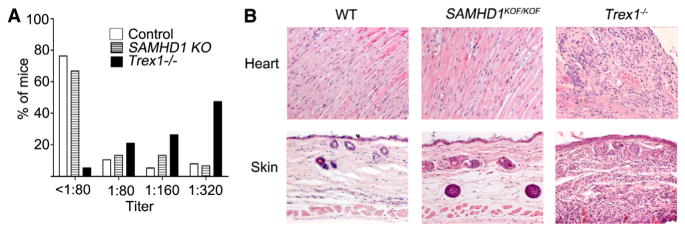
Spontaneous IFN Release Does Not Result in Autoimmune Disease in SAMHD1-Deficient Mice(A) ANAs were detected by immunofluorescence analysis on murine fibroblasts. The significance of differences in ANA prevalence between groups was tested by chi-square test (Pearson) with Bonferroni correction. Autoantibodies occurred more frequently in Trex1−/− mice (n = 19, mean age 10 weeks) compared with controls (Ctrl, p < 0.0001, n = 38, mean age 15 weeks) or SAMHD1-deficient mice (SAMHD1 KO, p < 0.005, n = 15 [this group comprised SAMHD1KOF/KOF and SAMHD1Δ/Δ mice, mean age 20 weeks]). No significant increase in ANA frequencies could be detected in the SAMHD1-deficient versus the control group. (B) Absence of inflammatory changes in heart and skin from SAMHD1-deficient mice. H&E-stained sections of heart and skin from one WT, one SAMHD1KOF/KOF animal, and one diseased Trex1−/− animal from our facility, representative of 13 SAMHD1KOF/KOF mice analyzed (2 mice 16 weeks old, 11 older than 53 weeks) and five SAMHD1Δ/Δ mice (3 mice 9–15 weeks old, 2 older than 43 weeks).See also Figure S4.